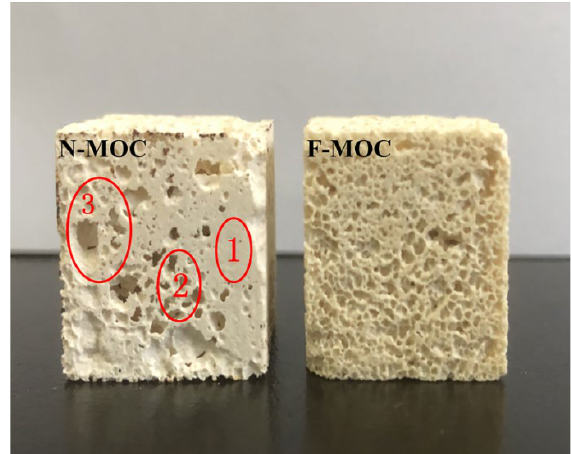
Figure 4. Comparison of the morphology of F-MOC and N-MOC with a similar bulk density ( the bulk density of F-MOC and N-MOC is 500–600 kg·m −3 ) .